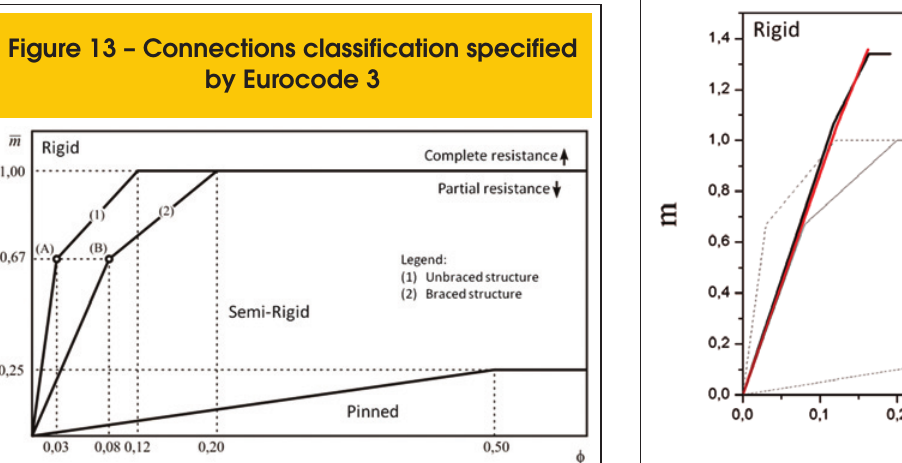
Figure 13 – Connections classification specified by Eurocode